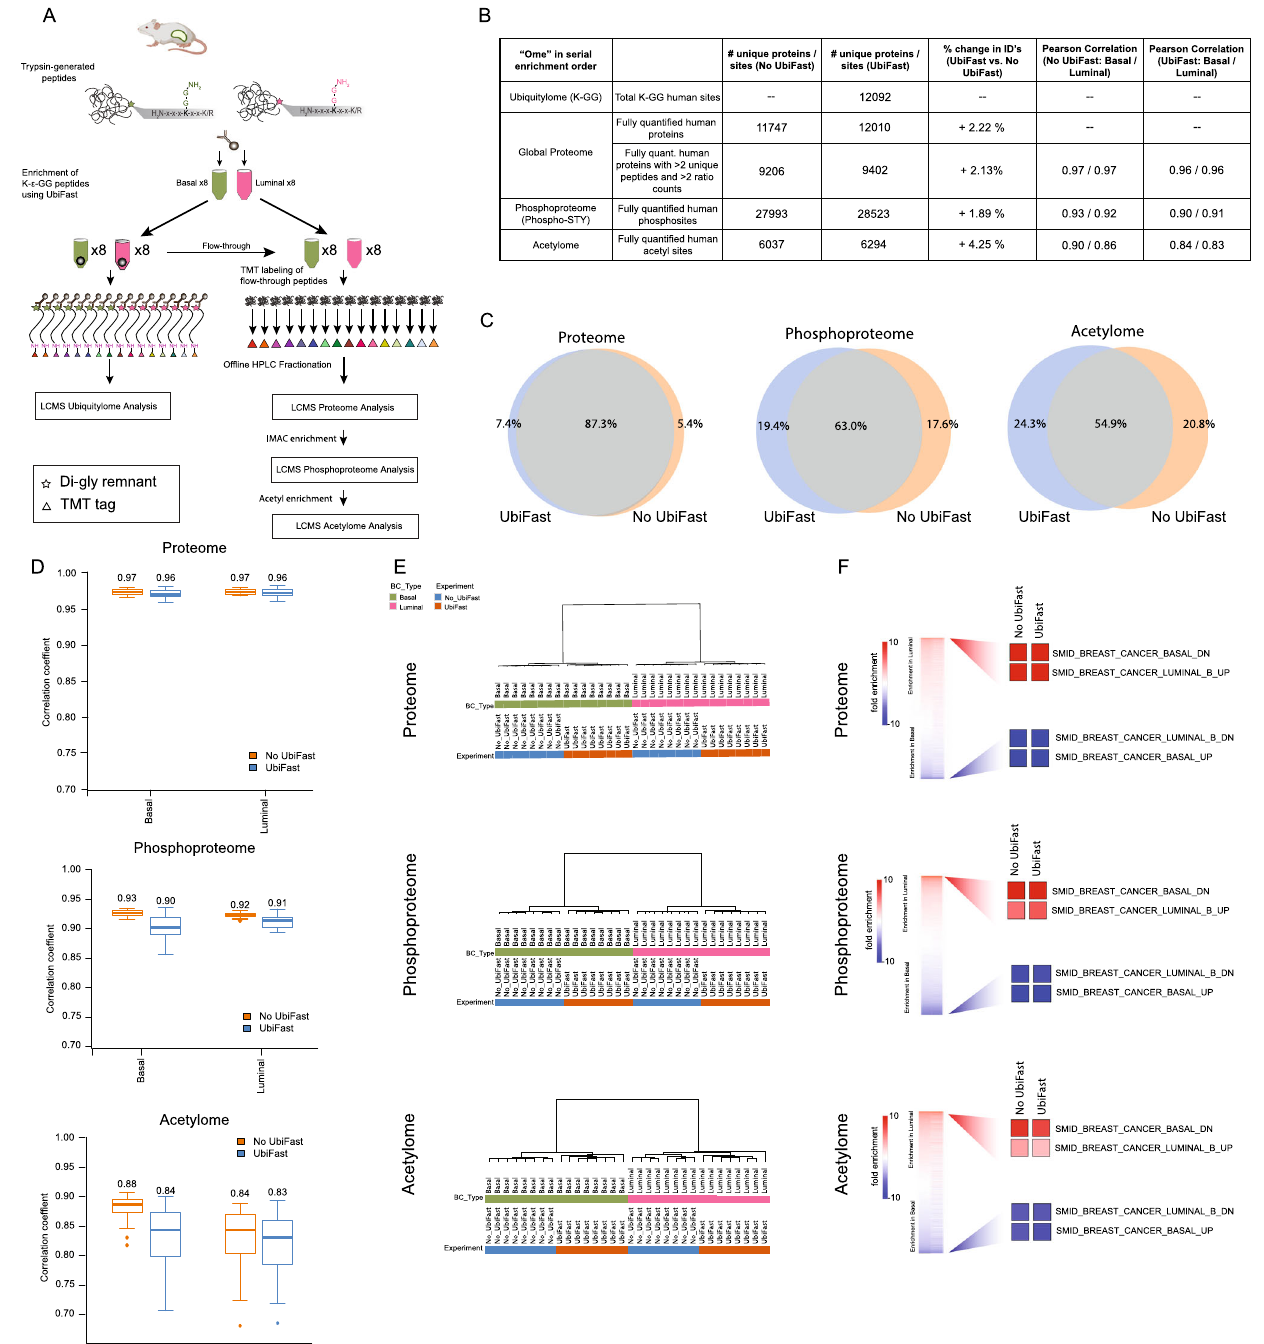
Fig. 2 | Comparison of the proteome and phosphoproteome of PDX samples with and without UbiFast for pre-enrichment of ubiquitylated peptides. A Experimental design used to analyze K- ɛ -GG peptides, proteins, and phospho- peptides from the same luminal and basal PDX breast cancer samples. The results for PDX samples processed directly for proteome and phosphoproteome were compared with samples initially enriched for ubiquitylated peptides using UbiFast and the fl ow-through of the UbiFast enrichment then used for proteome and phosphoproteome;250 µ gpeptideinputwasusedperTMTstate. B